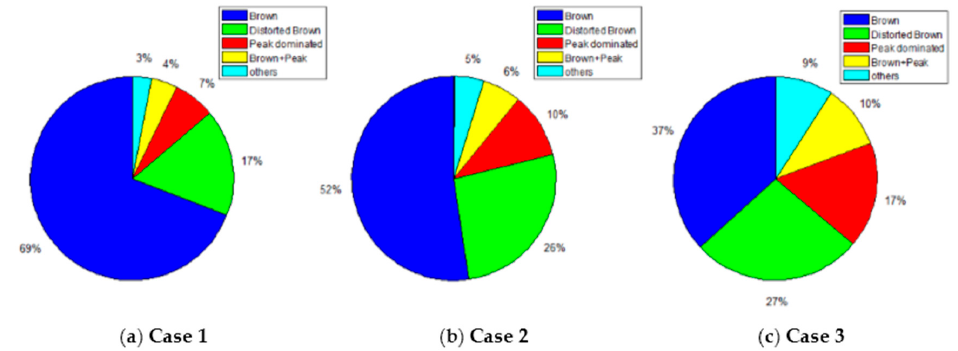
Figure 7. Percentages of waveform categories in the 3 cases.